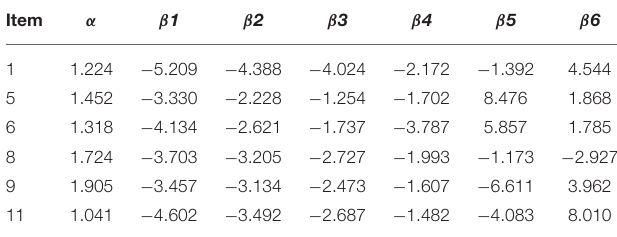
TABLE 2 | The item parameters of 10 selected